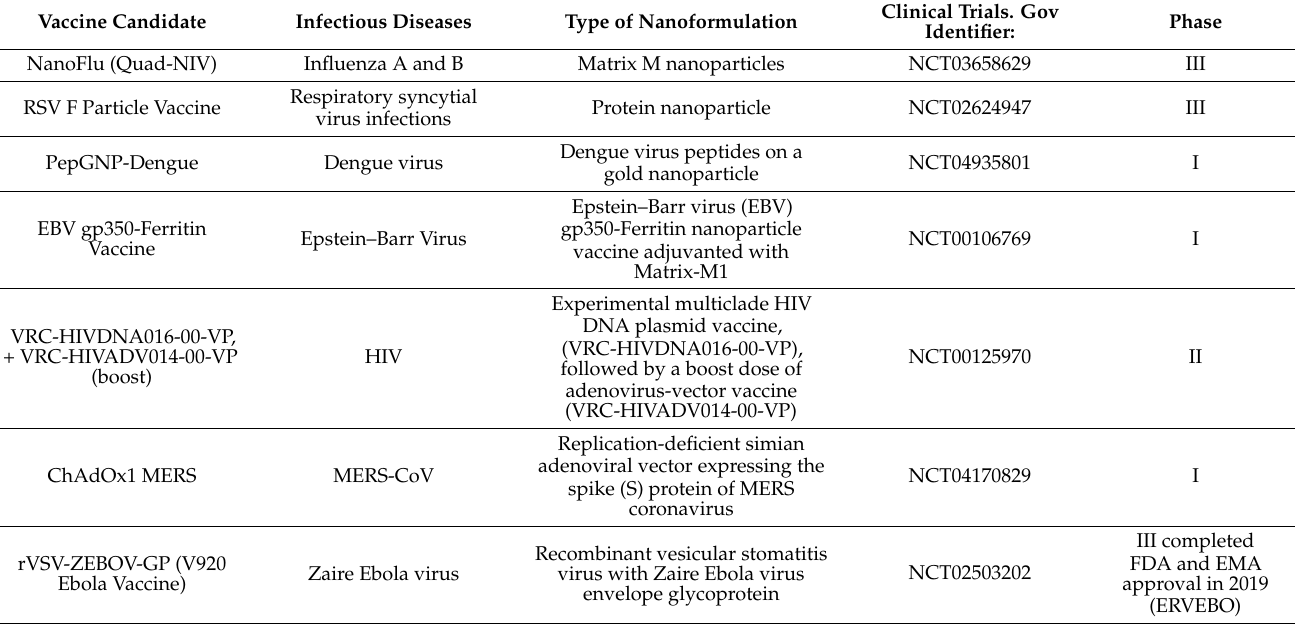
Table 1. Viral nano-based vaccines in different clinical trial